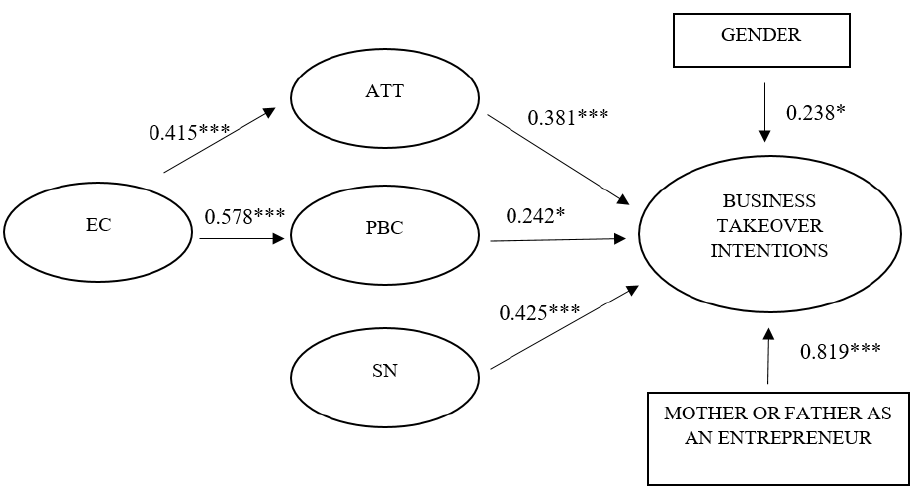
Figure 1. Final model for business takeover intentions with standardized coefficients. Note: *, *** indicate significance at the 90% and 99% level respectively.